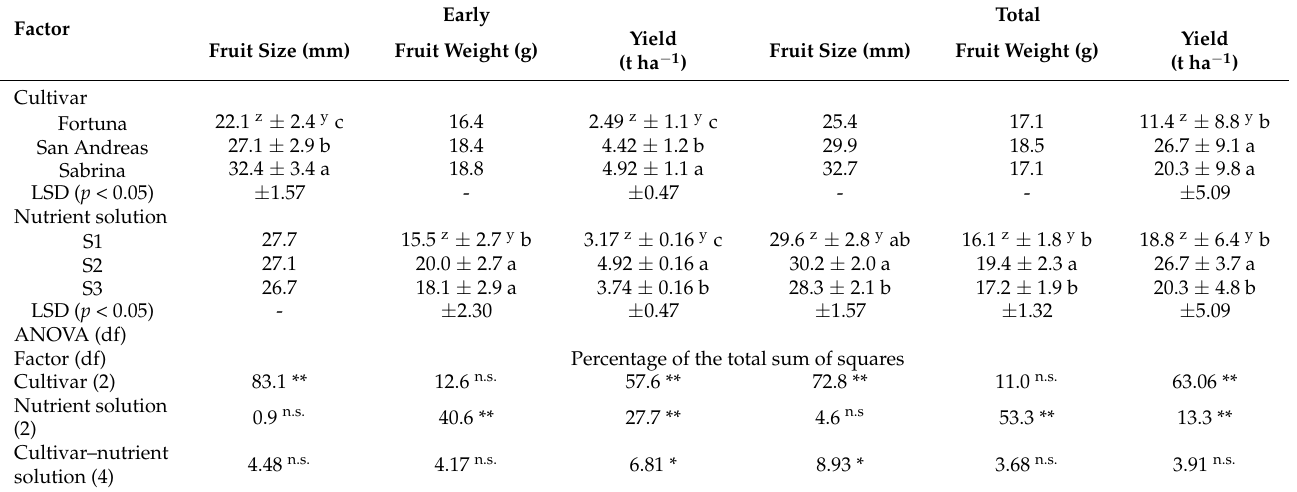
Table 3. Mean values, standard error ( ± ) and analysis of variance of productivity parameters (fruit size, weight and yield) for early (31 March) and total production (30 June) for three strawberry cultivars (Fortuna, San Andreas and Sabrina) irrigated with three nutrient solutions.